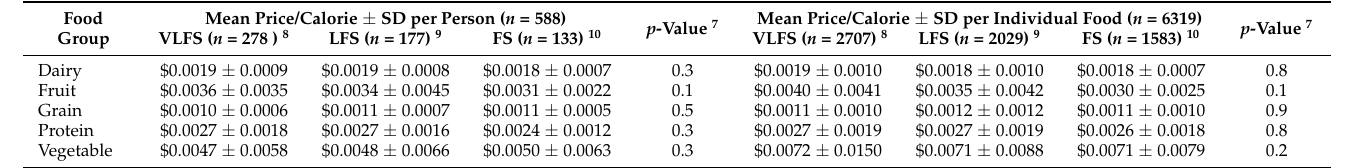
Table 5. Mean price per calorie for reported 24-h dietary intake by food group among adults using rural, Midwestern food pantries recruited in 2014 6